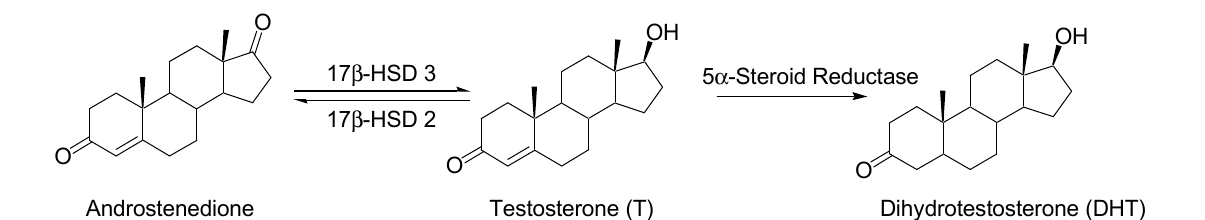
Figure 1. The role of 17 β -HSD Type 3 in androgen synthesis.